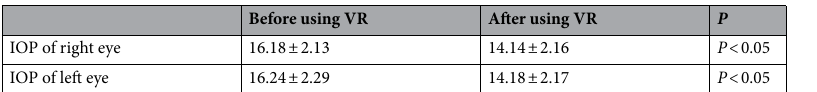
Table 3. Intraocular pressure changes, in unit mmHg, before and after the use of VR for watching 3D videos.